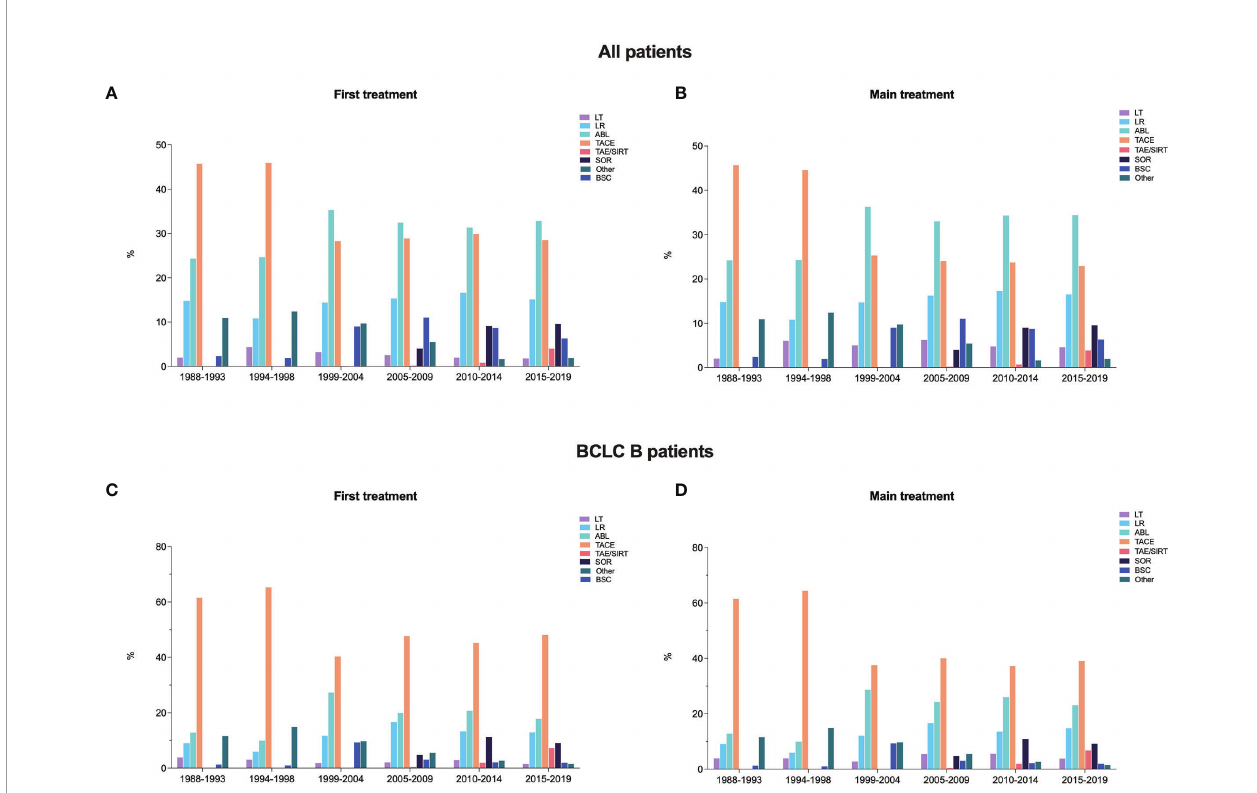
FIGURE 1 | Distribution of the fi rst and main treatment adopted in the overall population of patients (A, B) and in BCLC B patients (C, D) in the six time periods